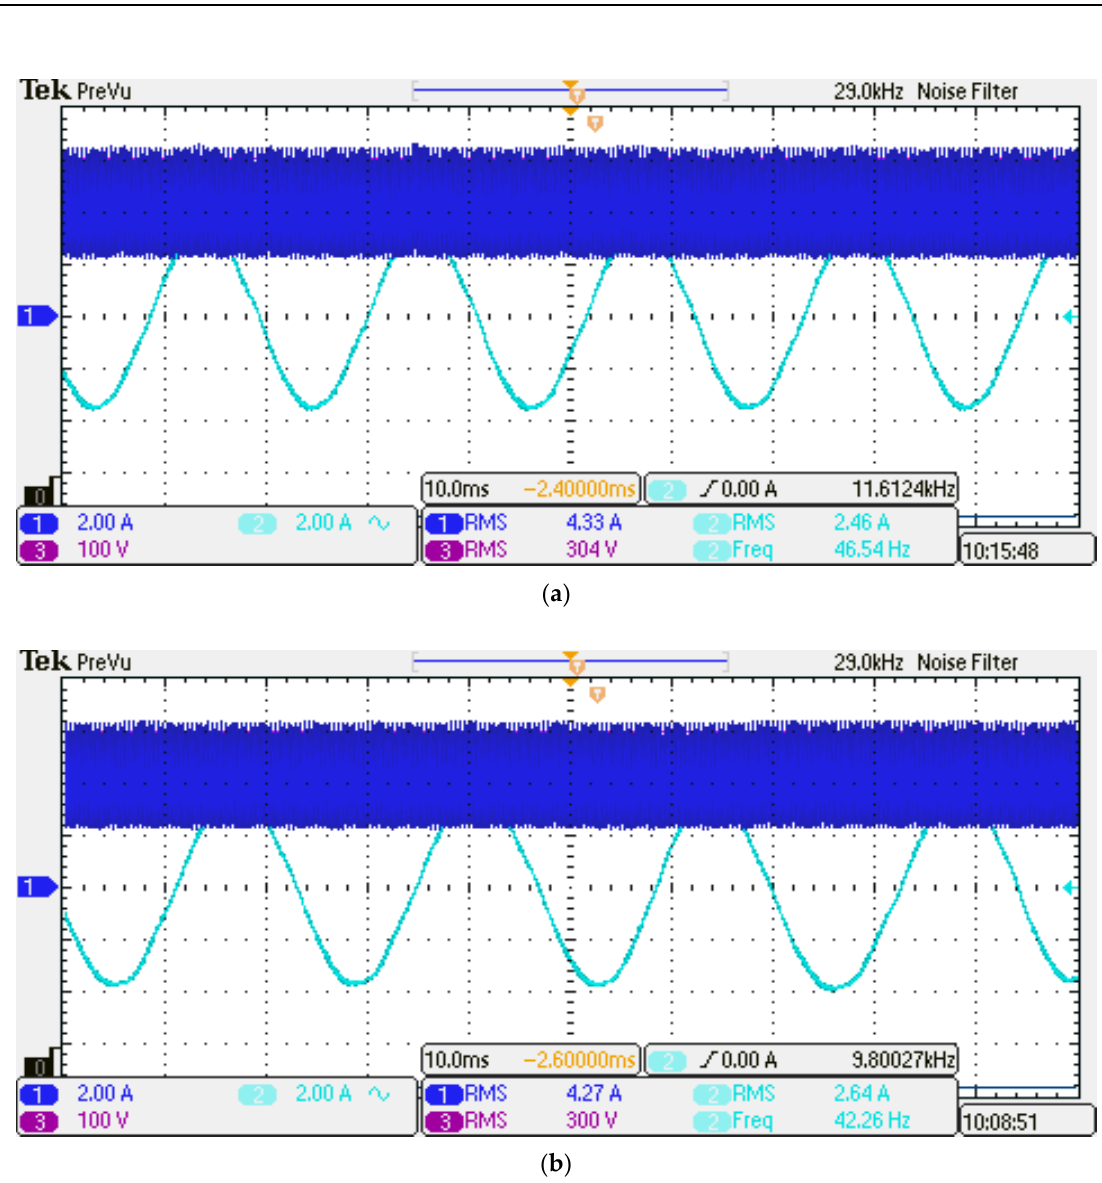
Figure 10. Experimental results at 4 A of the inductor current: ( a ) the proposed Q V/f; ( b ) the conventional L V/f PI-PI.